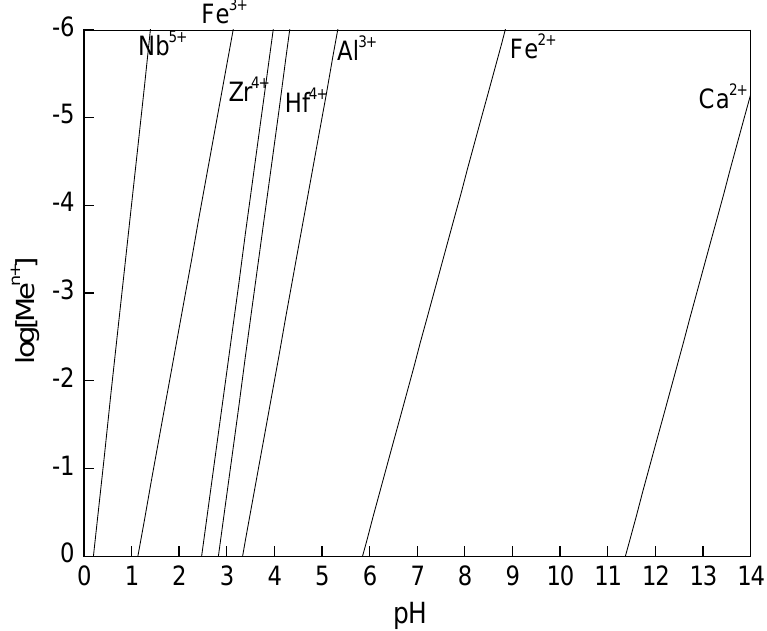
Figure 1. log[Me n+ ]-pH diagram based on the solubility product constants (K sp ) of metals hydroxide at 298.15 K (K sp data obtained from the literature [22]).